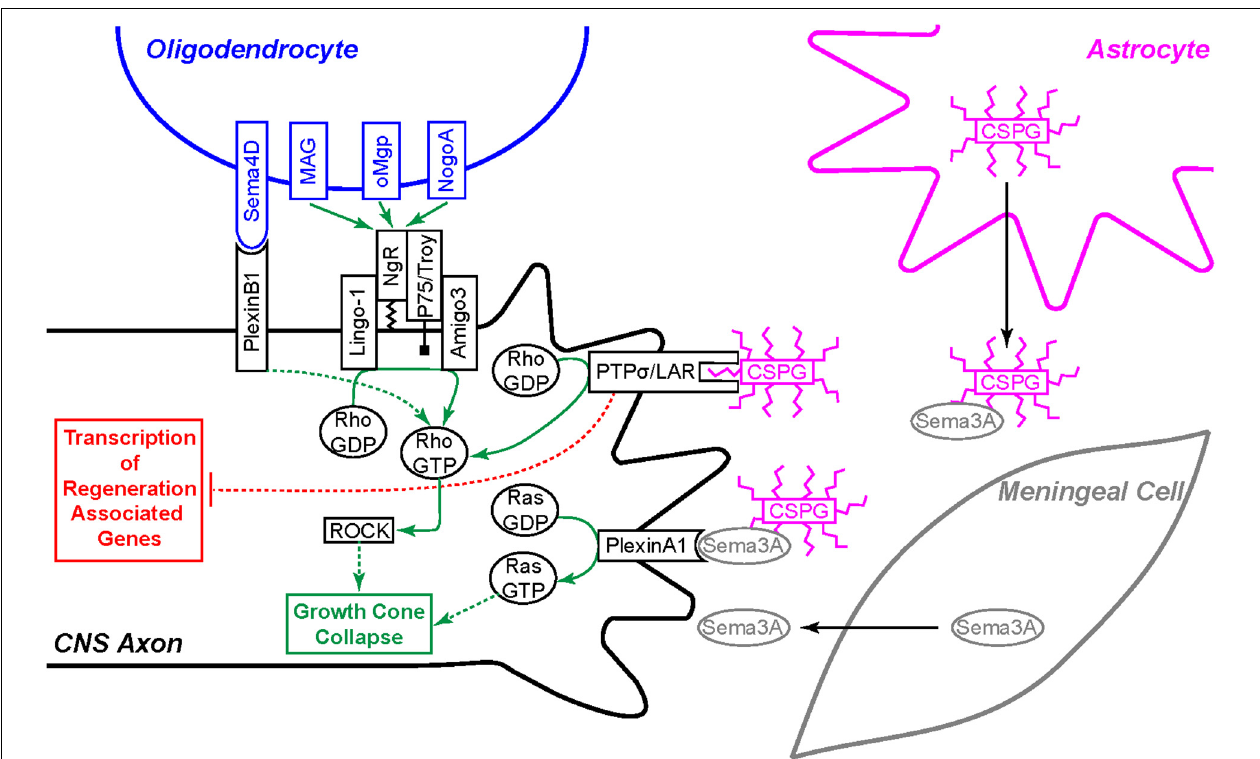
FIGURE 4 | Extrinsic inhibition of CNS axon regeneration. Oligodendrocytes express four membrane bound regeneration inhibitors: Sema4D, MAG, oMgp, and NogoA. Sema4D binds to the PlexinB1 receptor and the others bind to the Nogo-66 Receptor (NgR) complex expressed on the CNS axon. Each of these receptors signal growth cone collapse through the Rho/ROCK pathway. Invading meningeal cells in the glial scar secrete Sema3A molecules which associate with chondroitin sulfate proteoglycan (CSGP) glycosaminoglycan (GAG) side-chains and bind the PlexinA1 receptor to signal growth cone collapse through the activation of